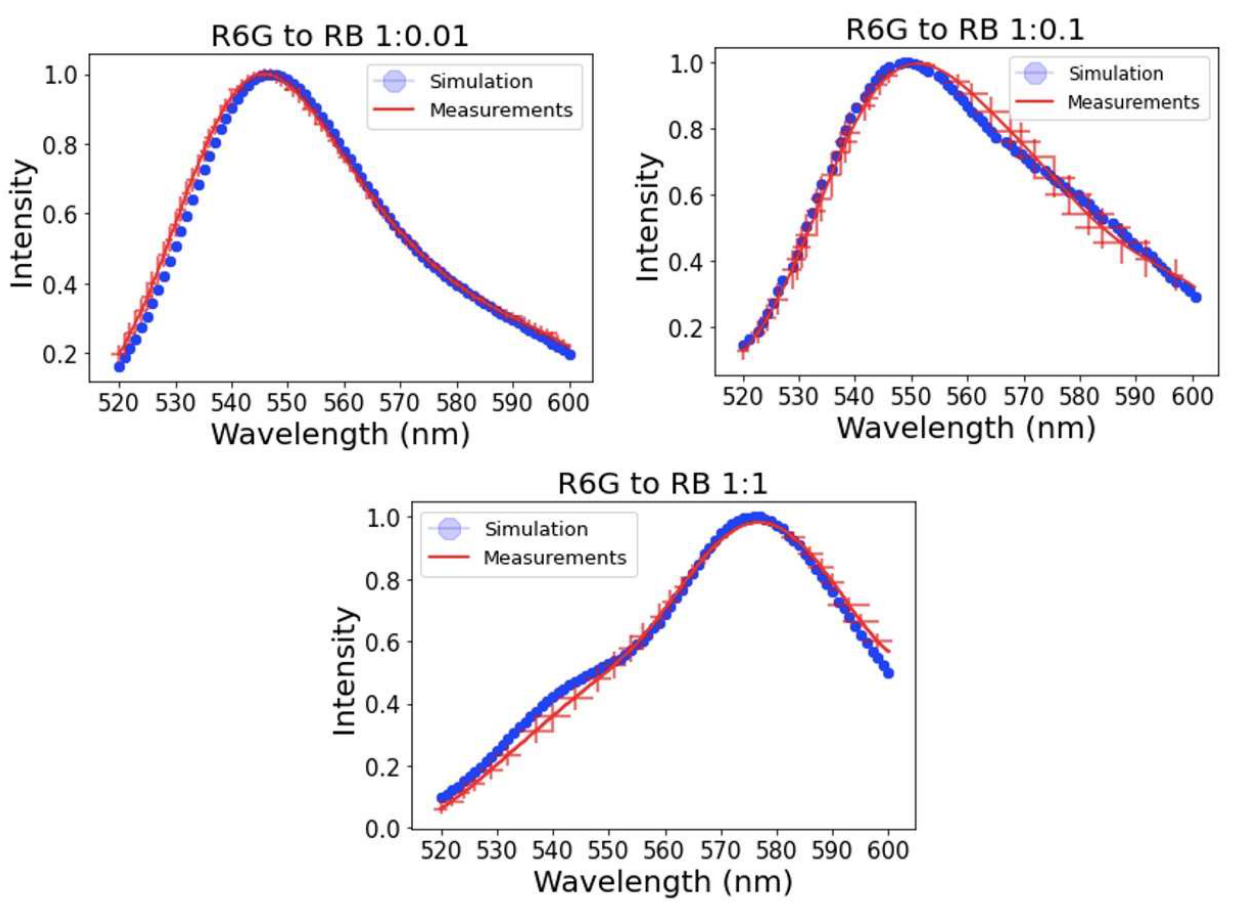
Figure 4. Fluorescence spectra of UNSNP with R6G to RB ratio of 1:0.01, 1:0.1, and 1:1. The blue line is the average fluorescence spectra from the simulation, and the red line is the fluorescence spectra measured on 10 individual nanoparticles. One standard deviation is shown for the measurements of intensity (the vertical line of the cross) and the averaged region on the wavelengths (the horizontal line of the cross).